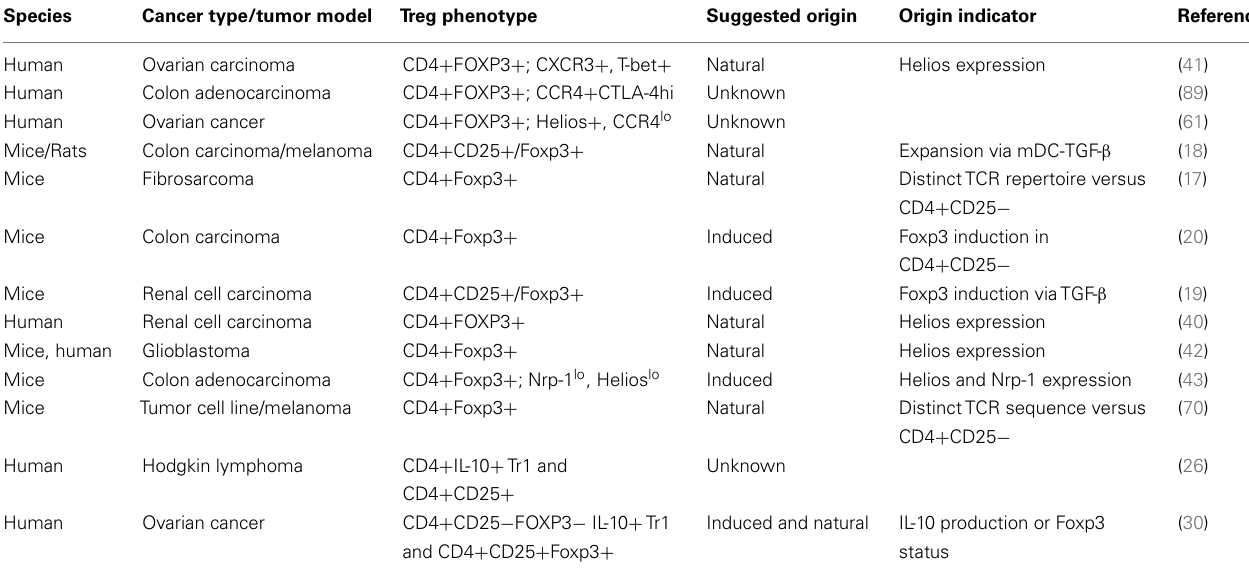
Table 1 | Natural and inducedTreg cells in